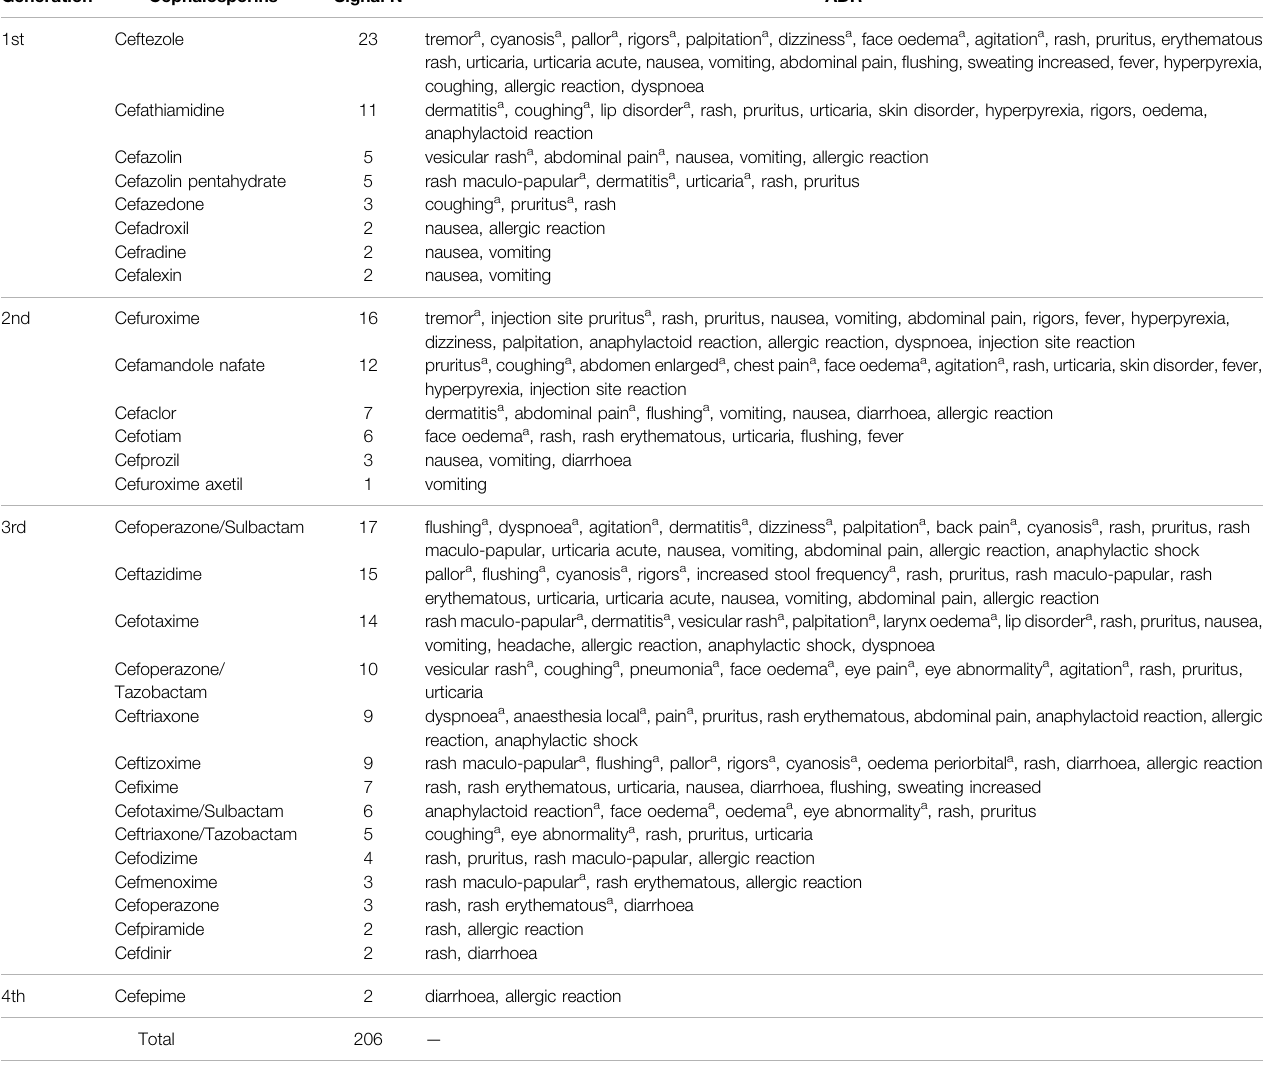
TABLE 9 | All positive ADR signals.